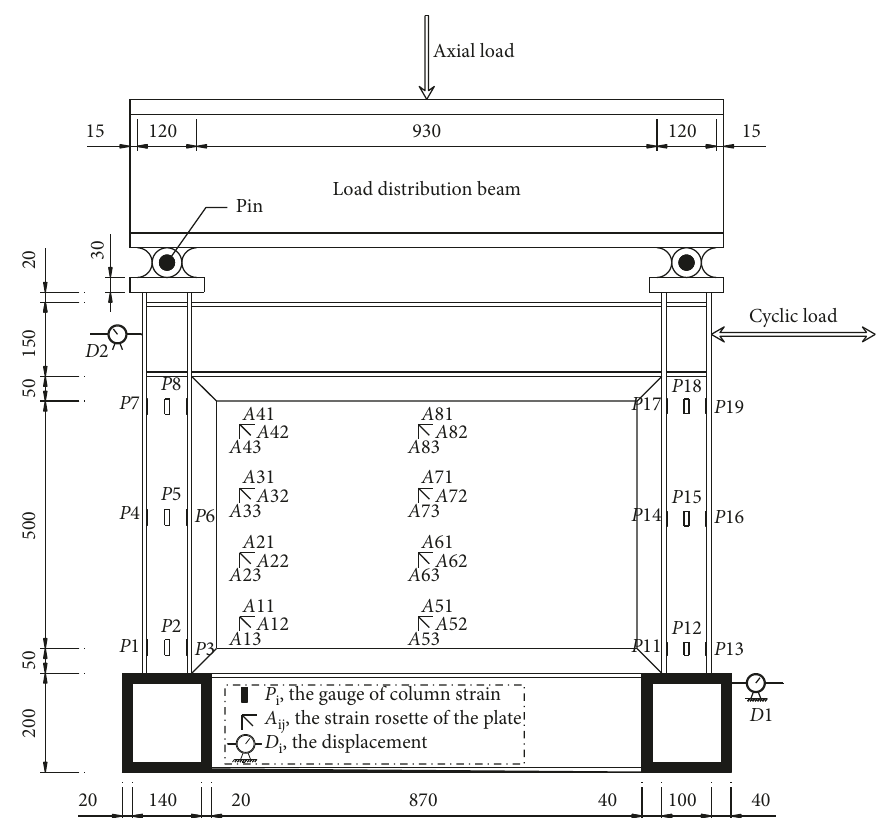
Figure 1: Dimensions of specimens (units: mm) and layout of strain gauges and LVDTs.